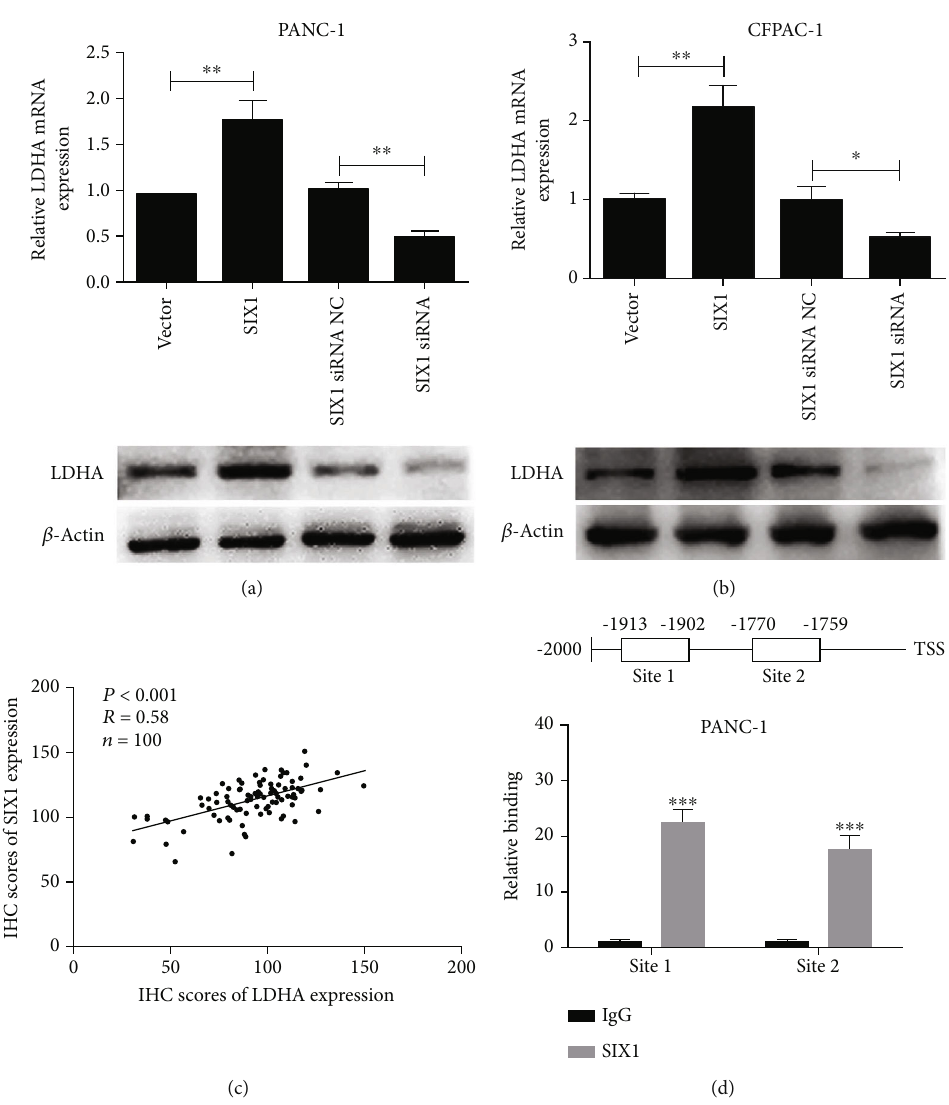
Figure 4: SIX1 directly targets LDHA in PC. (a, b) LDHA expression levels in SIX1-overexpressing or SIX1 knockdown cells were measured by qRT-PCR and western blotting, and β -actin served as the internal control. (c) In human PC tissues, LDHA was positively correlated with SIX1 expression. (d) A ChIP-qPCR assay demonstrated the direct binding of SIX1 to the LDHA promoter in PANC-1 cells. The data are presented as the mean ± SD from three independent experiments. ∗ P ≤ 0 : 05 , ∗∗ P ≤ 0 : 01 , and ∗∗∗ P ≤ 0 : 001